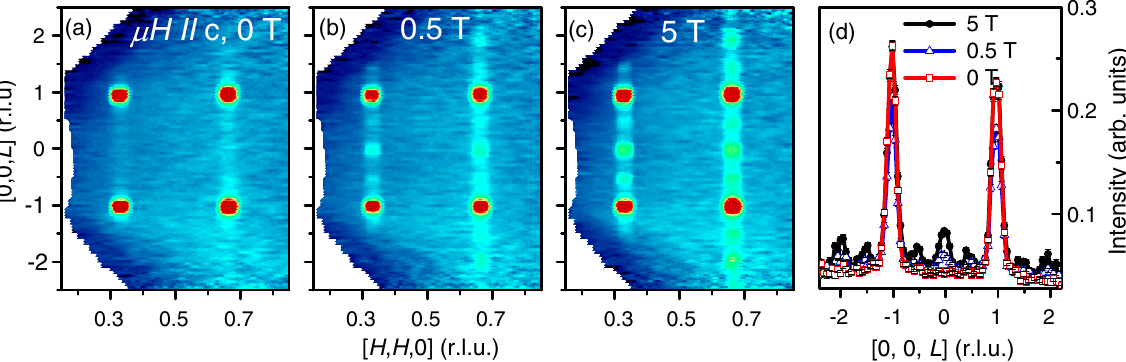
FIG. 12. (a) – (c) Evolution of scattering intensity in the ( H , H , L ) reciprocal plane for different magnetic fields applied along the c direction. Data demonstrate the development of strong structured diffuse scattering intensity along the L direction. (d) Cut along the diffuse scattering at the ( 2 , 2 , L ) position revealing prominent peaks centered at L ¼ 0 , (cid:4) 0 . 5 , (cid:4) 1 , and (cid:4) 1 . 5 3 3